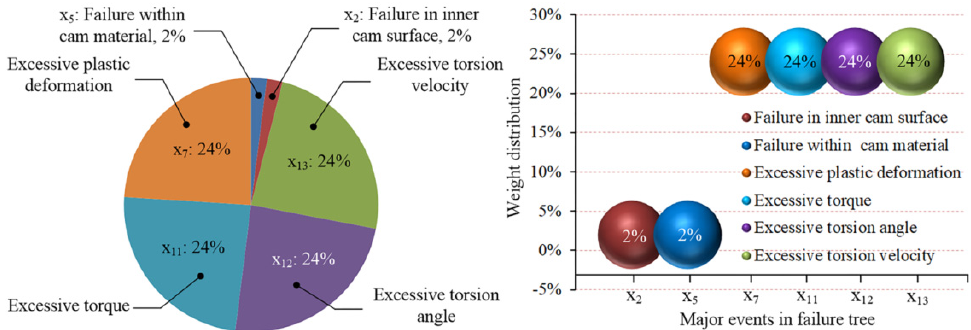
Figure 15. Weight distribution of major events in failure tree of assembled camshaft.